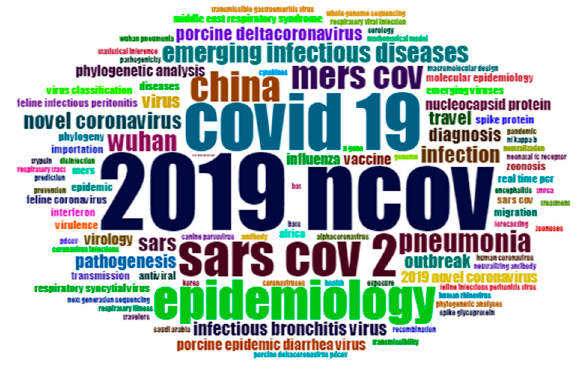
Figure 12. Keywords cloud map of 2020. Table 13. Top cited papers with over 40 citations of 2020.